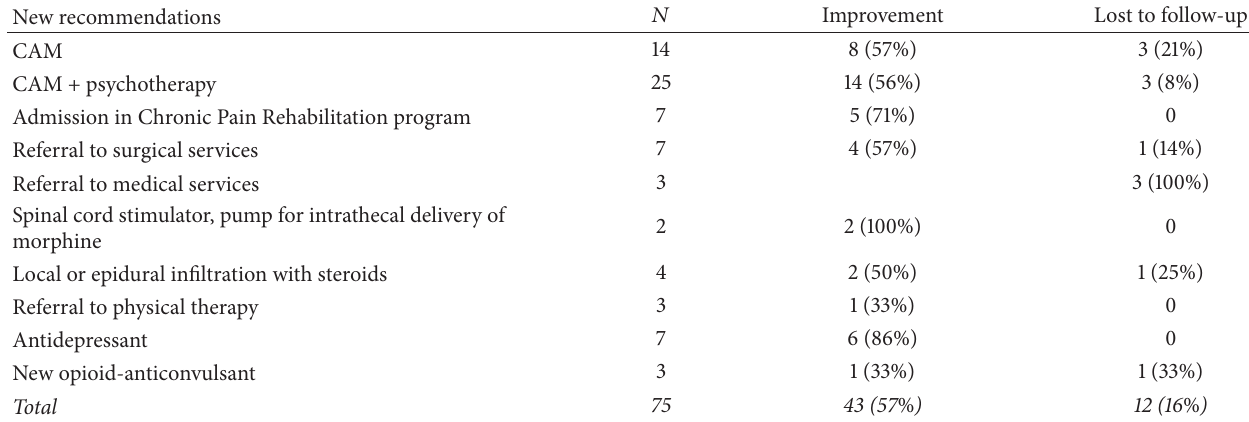
Table 5: Therapeutic interventions recommended by our team with outcomes (CAM: Complementary Alternative